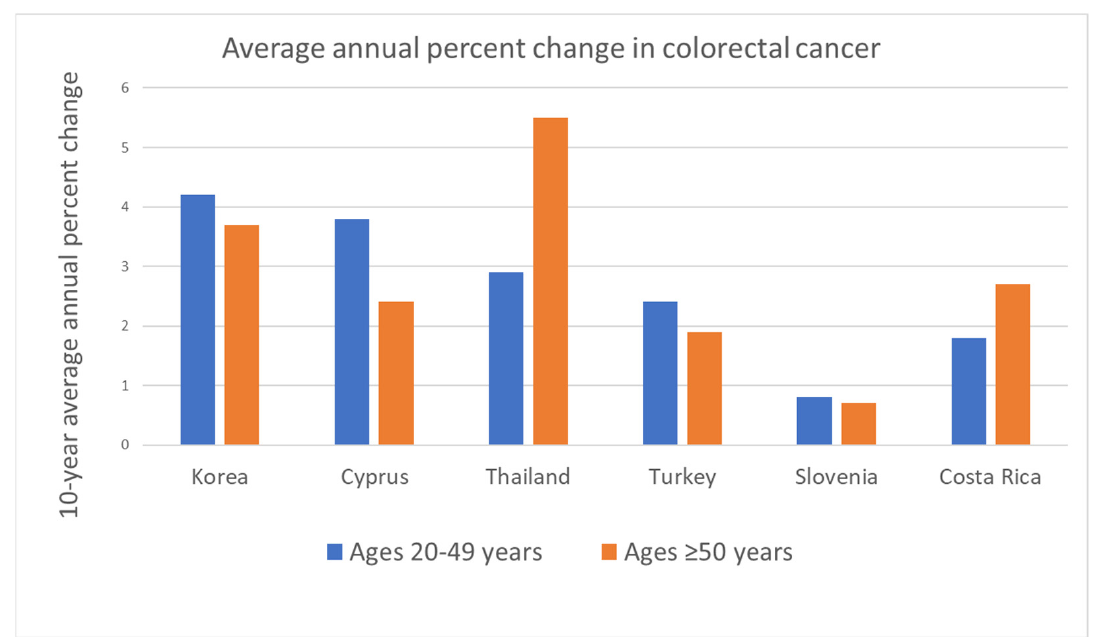
Figure 2. The countries demonstrate increasing colorectal cancer incidence rates in both younger and older populations. This graph is created based on the summary of the published articles by Sung, H. et al. [1] and Siegel, R.L. [12].